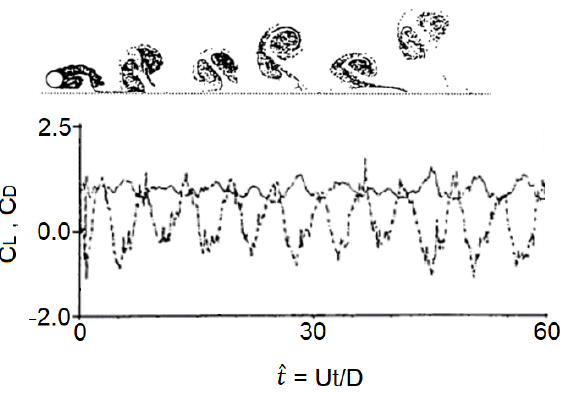
Figure 9. The flow pattern and force coefficients for G/D = 0.5 and Re = 100,000.